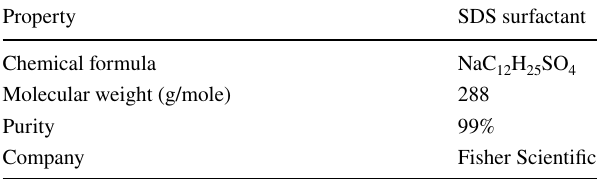
Table 2 Properties of SDS surfactant Property